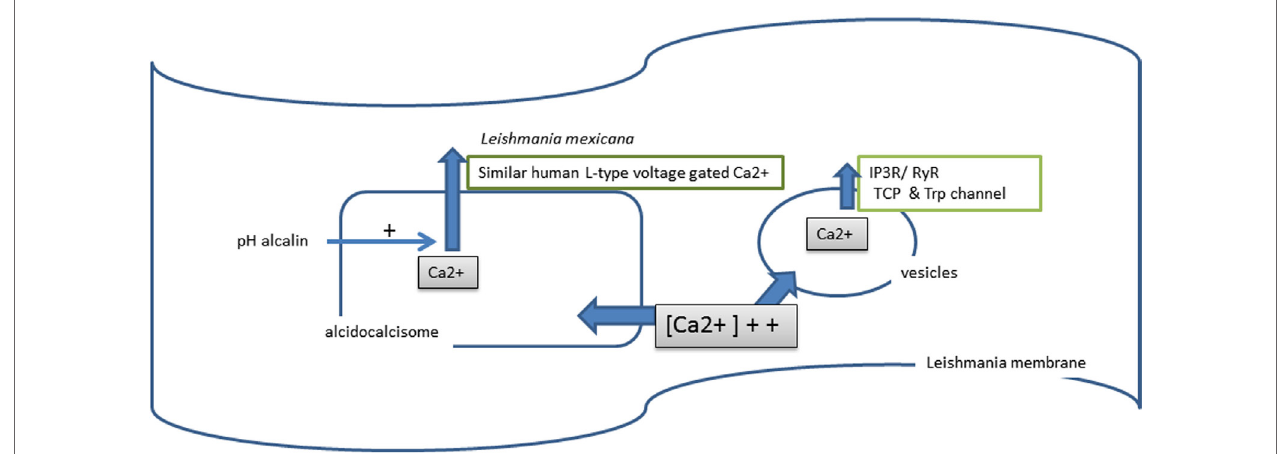
FiGURe 6 | Calcium used by Leishmania